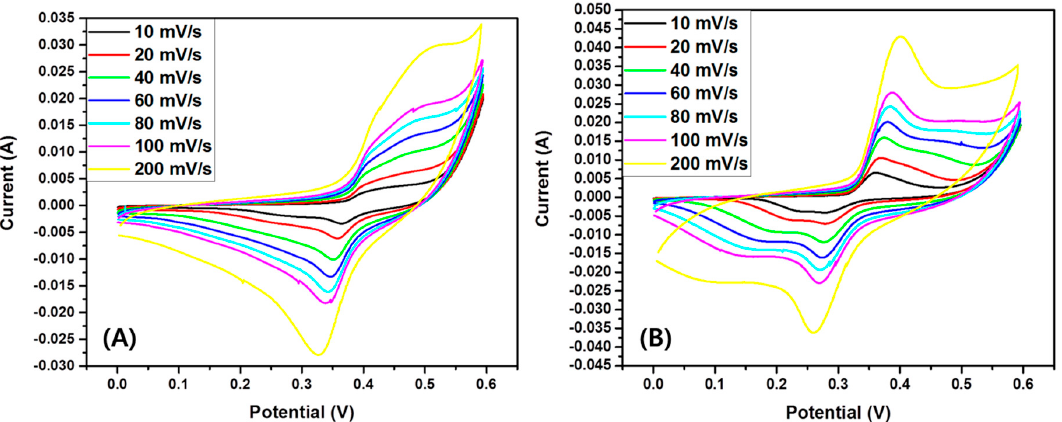
Figure 8. Cyclic voltammetry (CV) curves of pristine TiO 2 NFs ( A ) and TiO 2 -carbon NFs ( B ) at different scan rates.